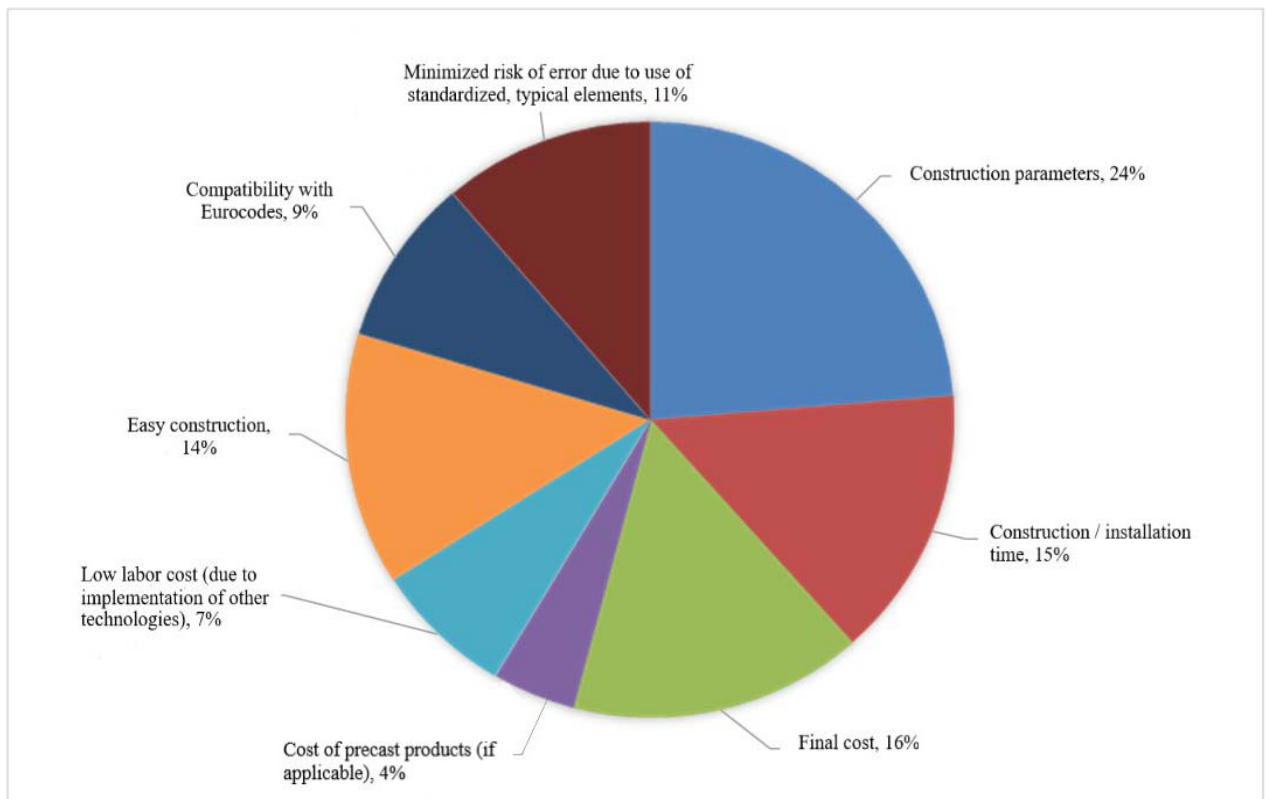
Fig. 2. Technical-economic criteria considered by the respondents when making decisions concerning the selection of a particular flooring system Source: Developed by the author based on the conducted